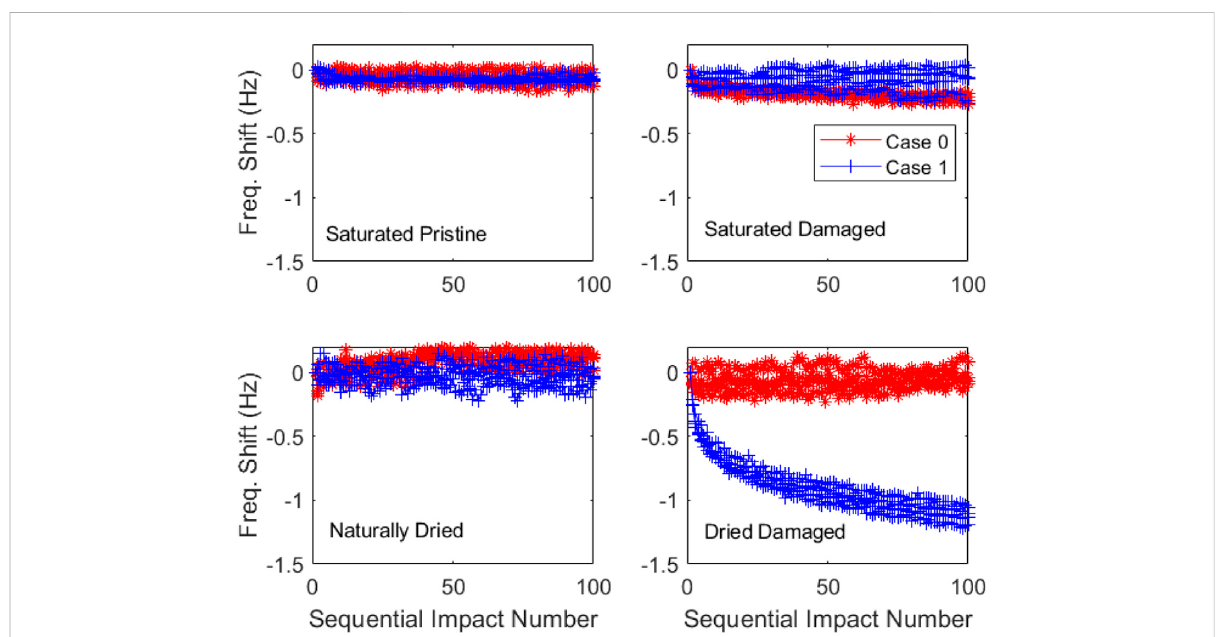
FIGURE 12 Sequentialimpacttestresultsforfourrandomlyselectedneatcementpastesamplesinthesaturatedpristineconditionbeforeexposure,Case0 (red),andthenthesamesampleafterdamageand/orenvironmentalexposure,Case1(blue).Therepresentativetestconditionsaresaturatedpristine (top left), saturated damaged (top right), naturally dried (bottom left), and dried damaged (bottom right). Case 0 represents the saturated pristine material condition before exposure to the subject